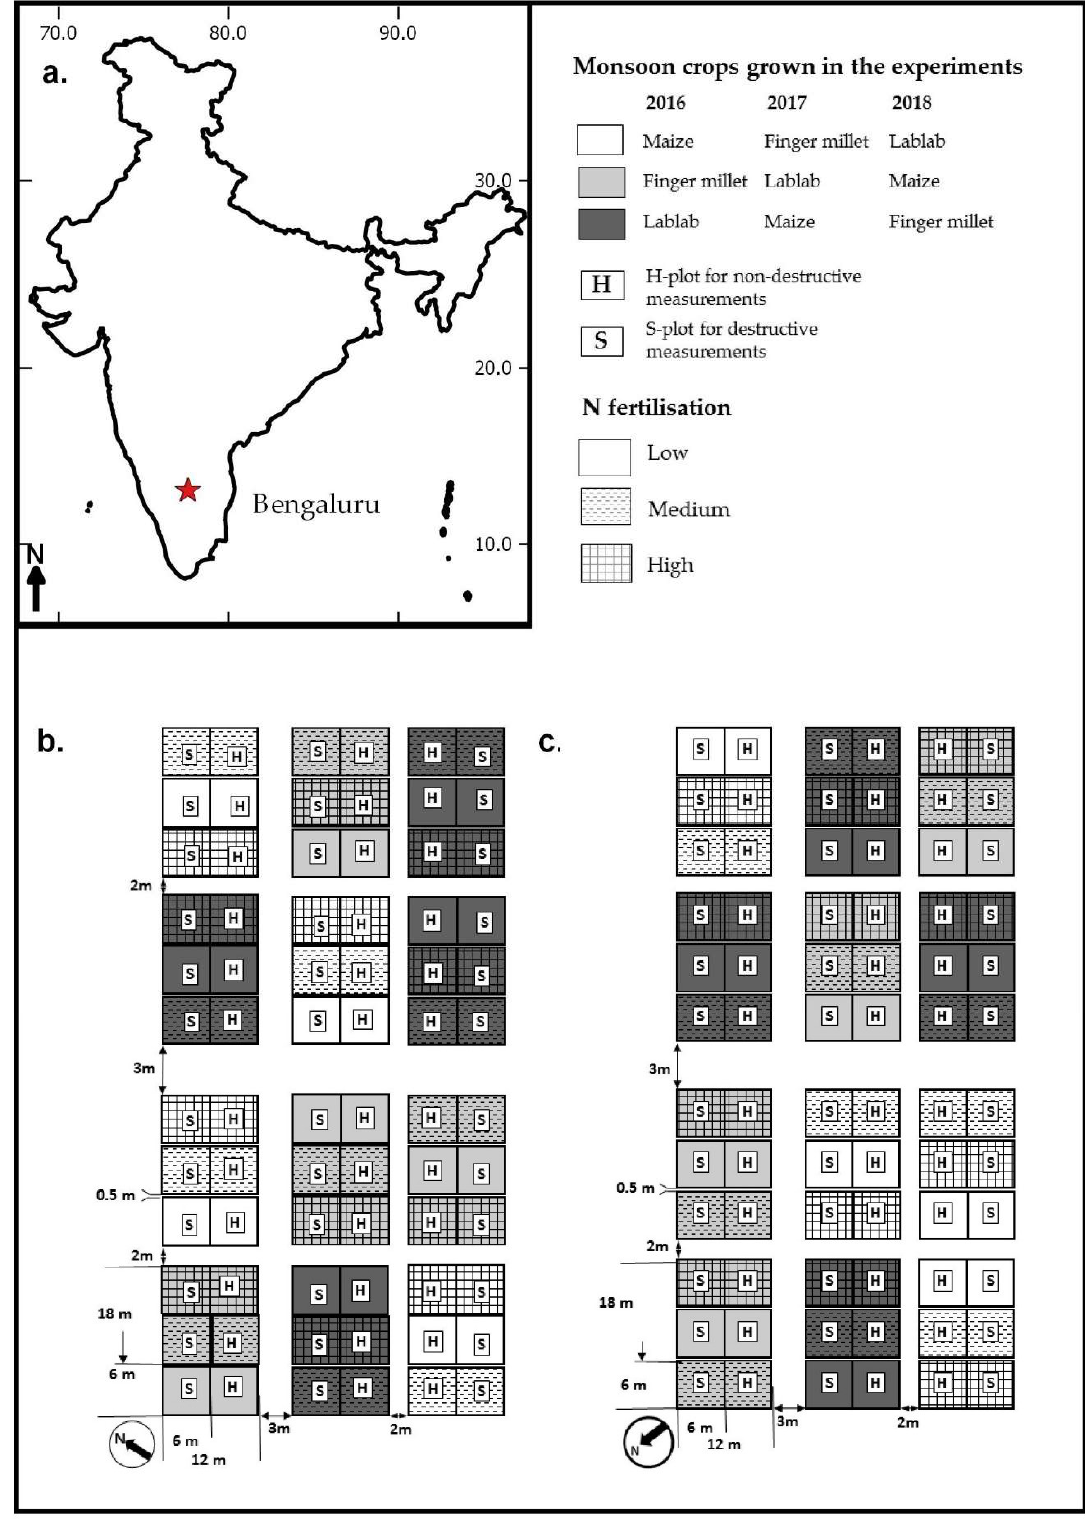
Figure 1. ( a ) Location of Bengaluru within India; ( b ) design of rainfed experimental layout; ( c ) design of irrigated experimental layout (adjusted from [11]).